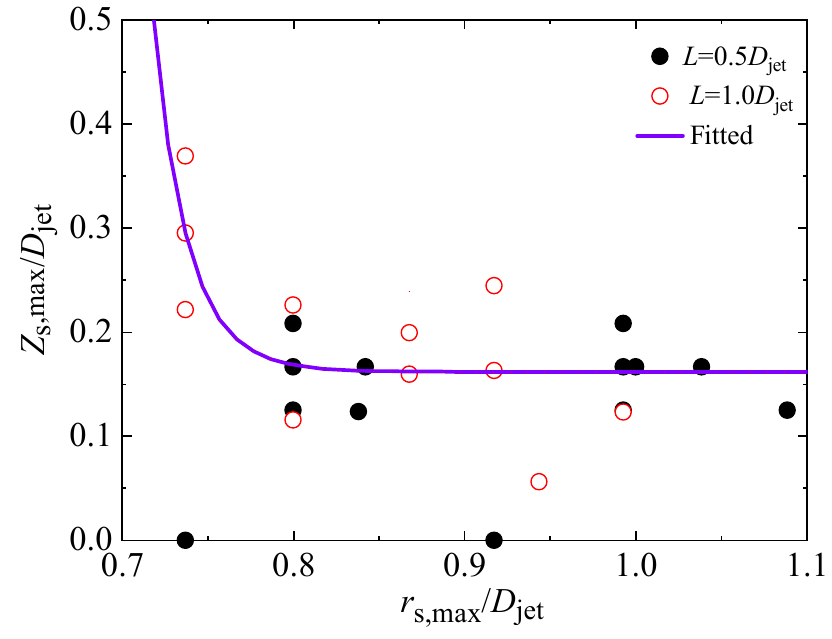
Figure 18. Z s,max versus r s,max .